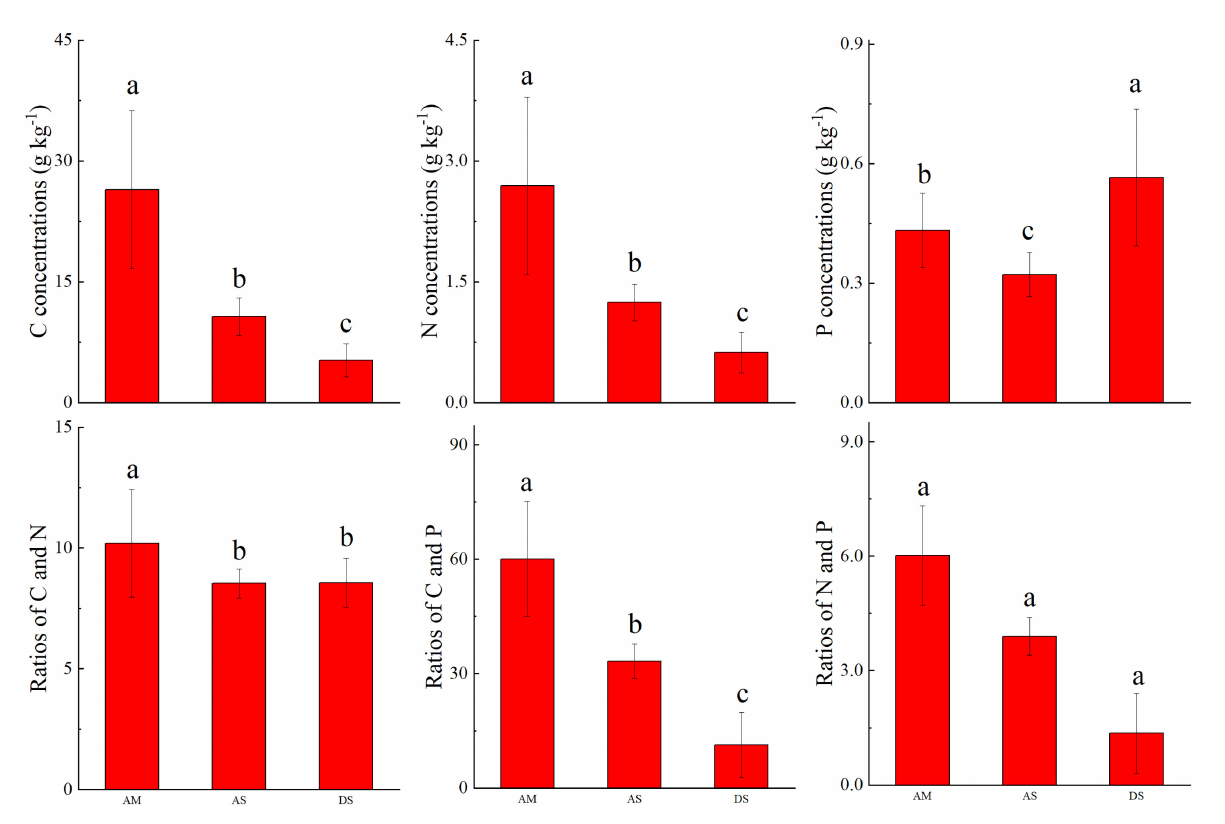
FIGURE 4 Comparison of soil C, N, and P stoichiometry in different grassland types. Different letters above the column means the differences was signi fi cant at 0.05